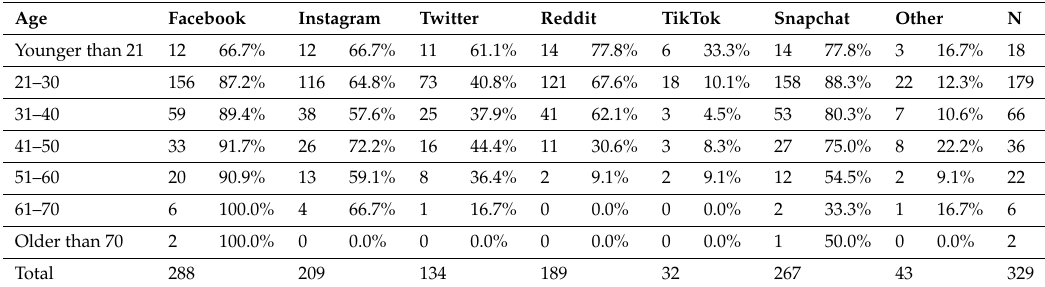
Table 5. The table shows the number of people who use the different kinds of social media. The first number is the number of respondents in that age group and the percentage is the percentage of people in the age group that use a given social media platform.